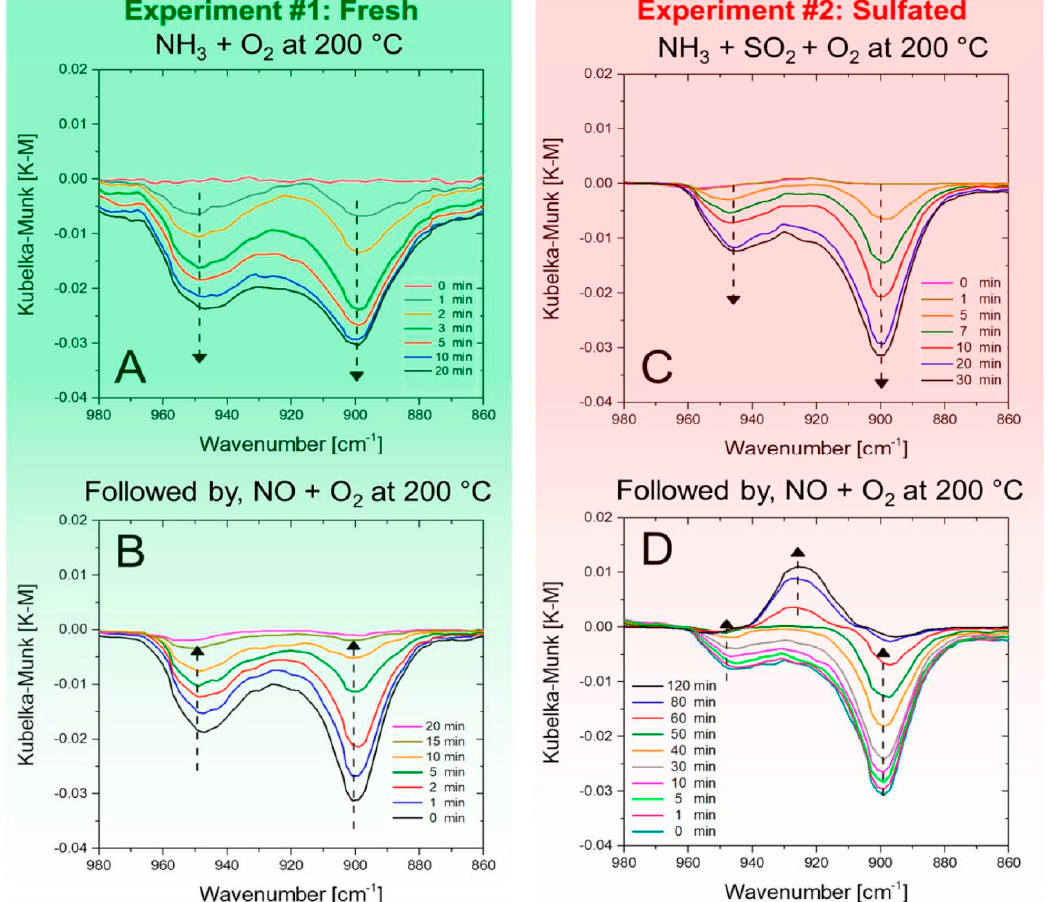
Figure 6. In situ diffuse reflection infrared Fourier transform spectroscopy (DRIFT) spectra of T-O-T vibrations of Cu-SSZ-13 during experiments with/without sulfur: ( A ) NH 3 + O 2 adsorption followed by a purging phase in He, ( B ) NO + O 2 adsorption at 200 °C, ( C ) NH 3 + O 2 + SO 2 adsorption at 200 °C followed by a purging phase in He, and ( D ) NO + O 2 adsorption at 200 °C. Reproduced with permission from [90], copyright American Chemical Society, 2018.